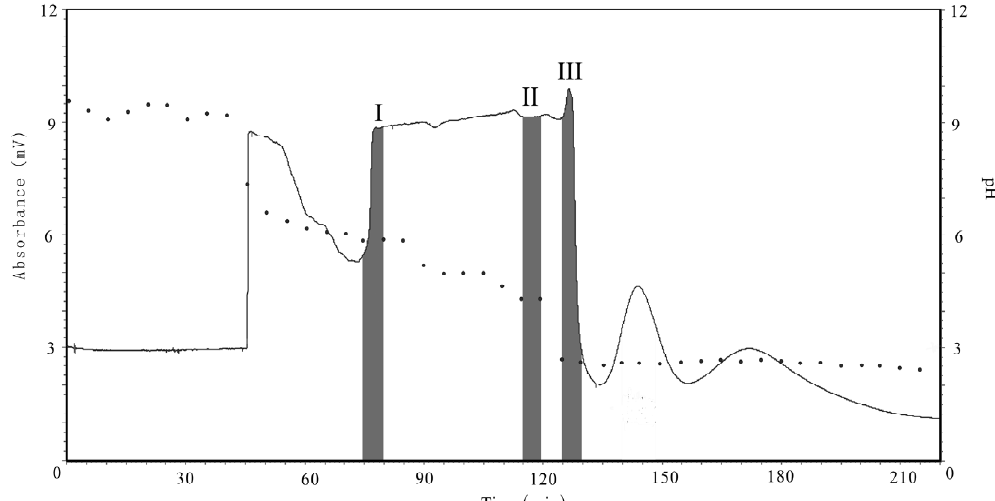
Figure 3. pH-zone-refining counter-current chromatogram (solid line) and pH value (dashed line) for each CCC fraction. Experimental conditions: solvent system: hexane- ethyl acetate-methyl alcohol-water (1:6:1:6, v/v ), including 10 mM TEA in the upper organic stationary phase and 5 mM HCl in the lower phase; retention of stationary phase: 34%; flow-rate: 2.0 mL/min; UV detection: 254 nm; revolution speed: 600